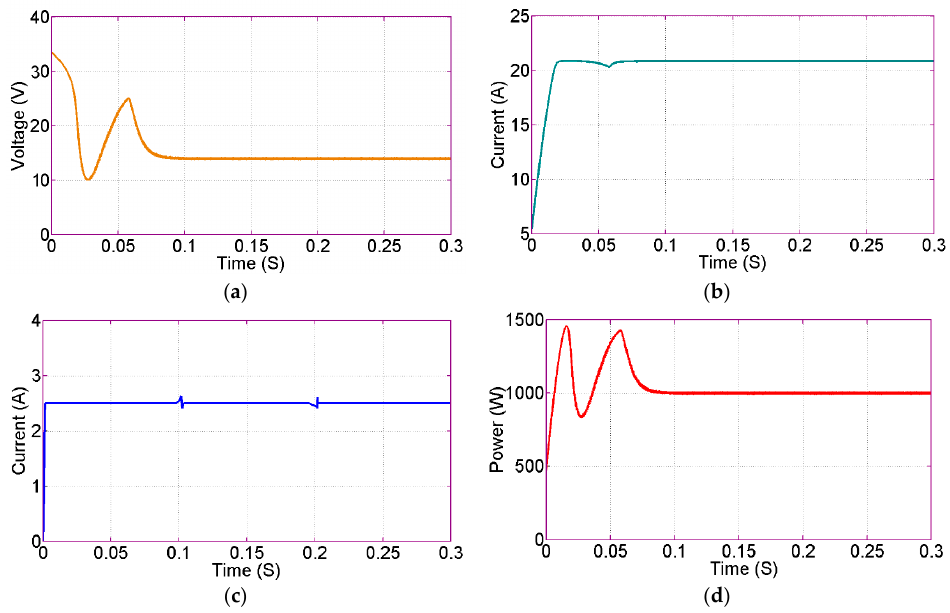
Figure 9. Simulation results under the steady state voltage and current: ( a ) PV array voltage; ( b ) PV current; ( c ) DC link current; and ( d ) PV output